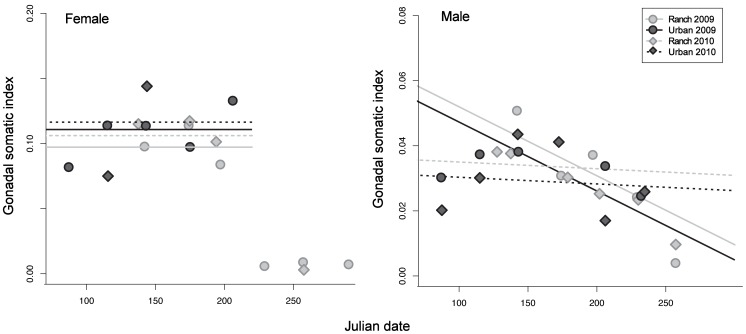
Variation in gonadosomatic index (GSI) by sex, site, and year.Points indicate the GSI of female (left panel) and male (right panel) fish collected at the ranch and urban beachs on the indicated sampling dates. Curves are linear regression fits; there was no significant effect of Julian date in female fish, and data collected after day 220 were excluded from the regression because no females were collected at the urban site.